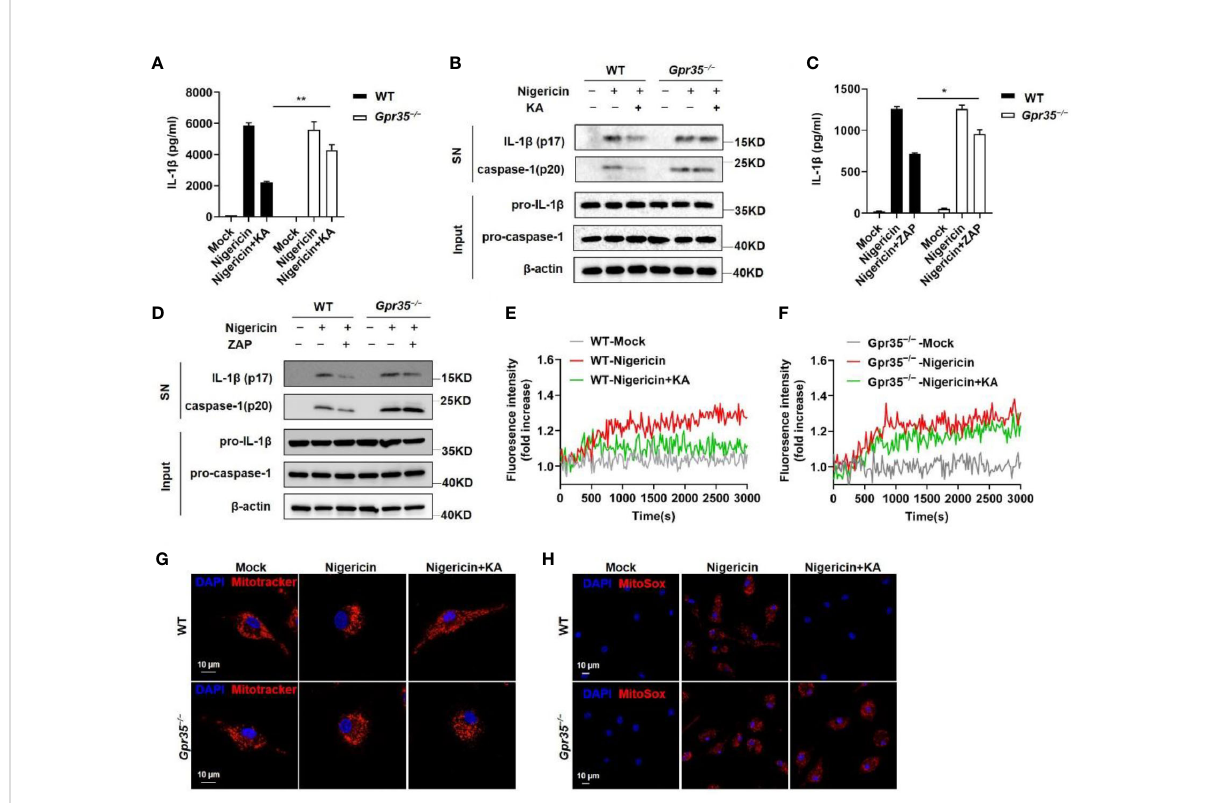
FIGURE 4 KA inhibited NLRP3 in fl ammasome activation via GPR35. (A, B) LPS-primed BMDMs from WT and Gpr35 − / − mice were treated with KA and